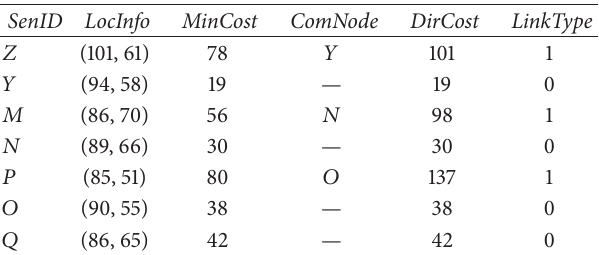
Table 3: Vicinity table (node 𝑋 ) after determining the ComNode between itself and its